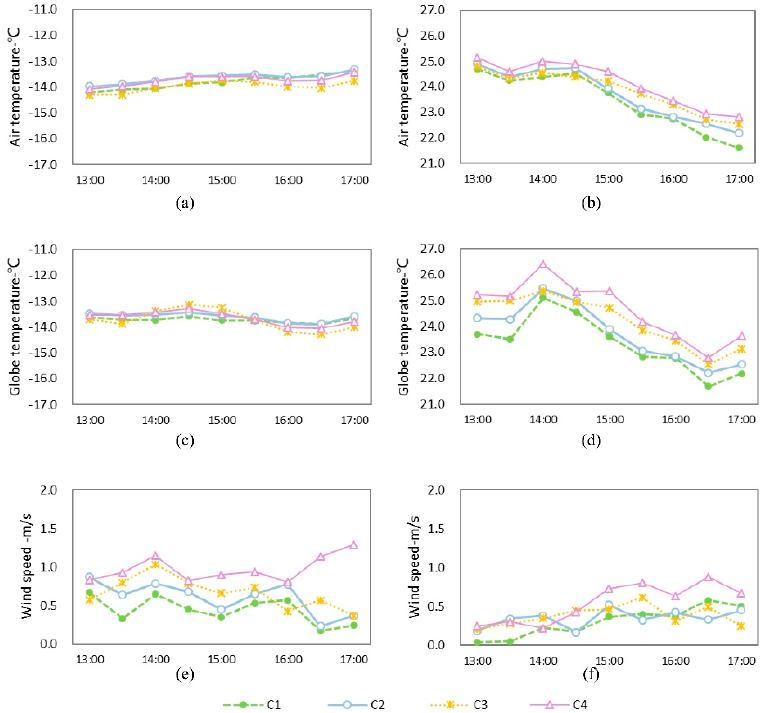
Figure 7. Variation curves of microclimate parameters in courtyards with different SVFs. ( a ) T a in winter; ( b ) T a in summer; ( c ) T g in winter; ( d ) T g in summer; ( e ) wind speed in winter; ( f ) wind speed in summer.